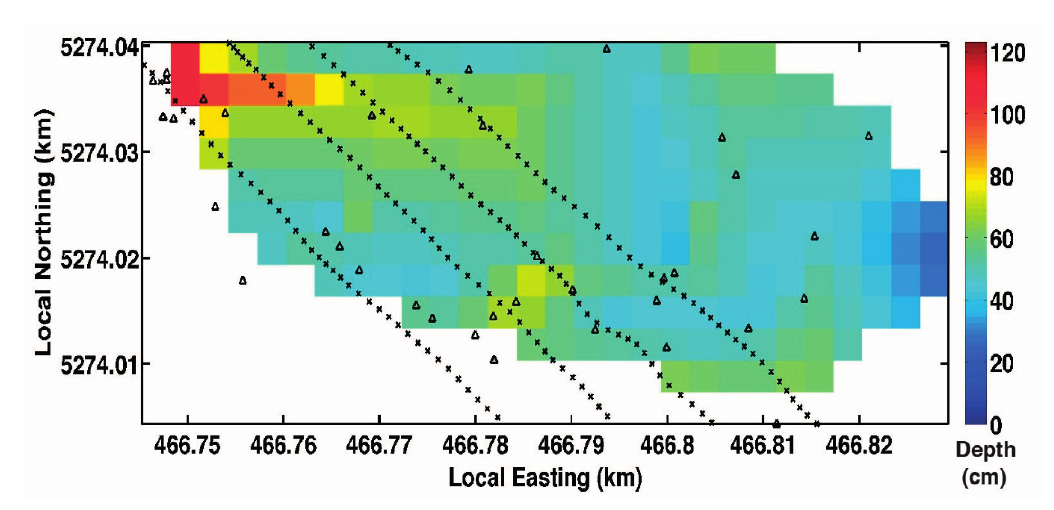
Figure 2. GPS measured snow depths from our study area that have been interpolated to a uniform grid at 3 m resolution. The black dots indicate image exposure locations along the unmanned aircraft system (UAS) flight trajectory, whereas the black triangles indicate measured snow depths.